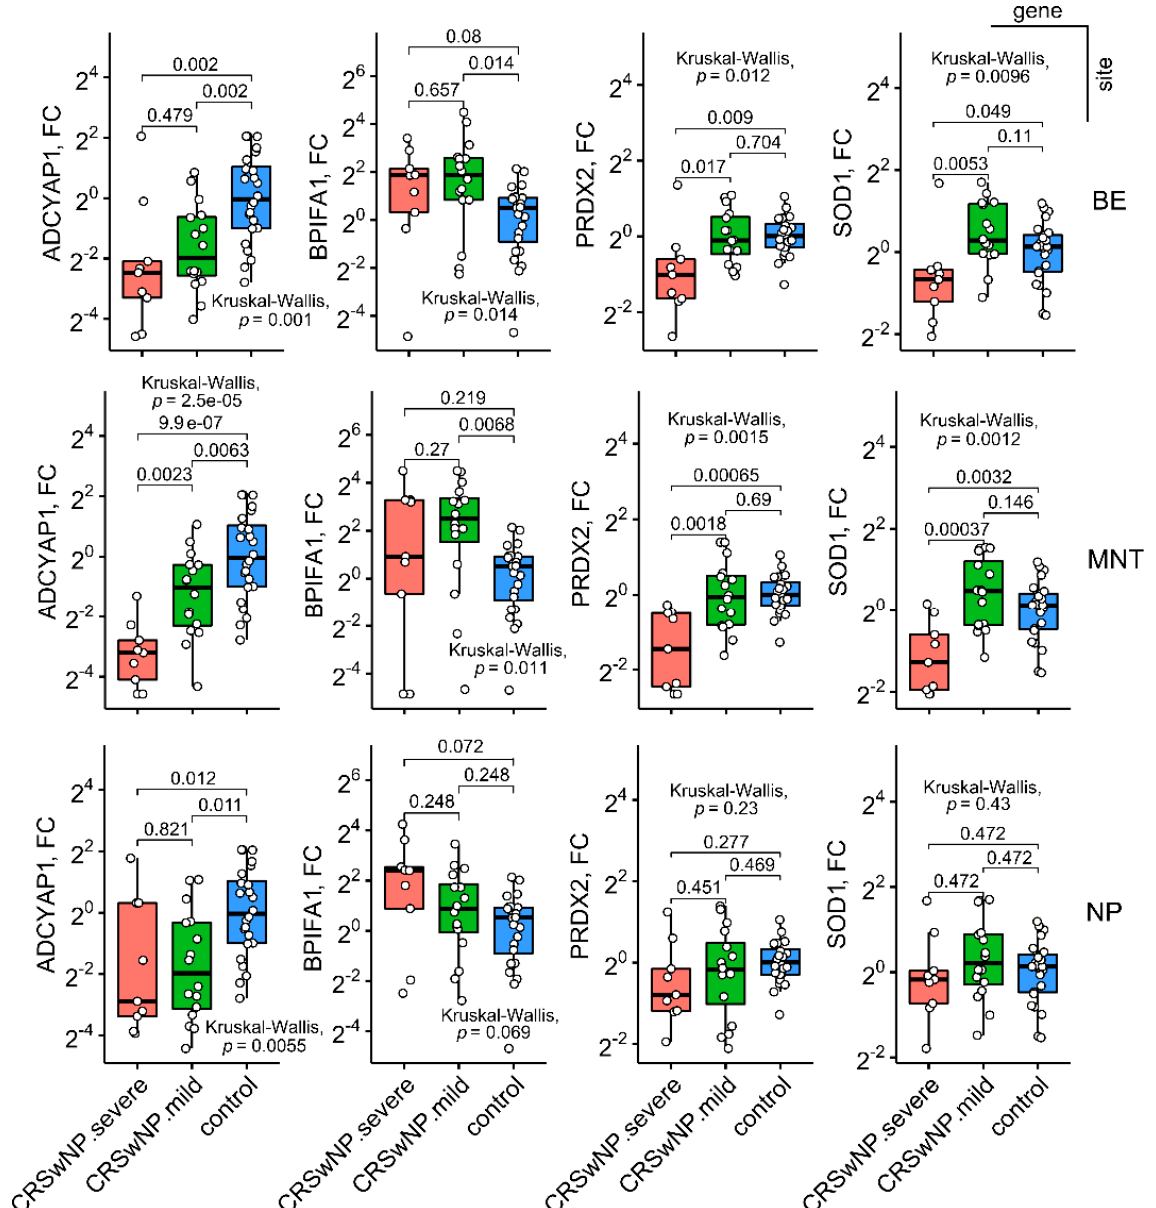
Figure 2. Boxplots showing gene expression (fold change (FC), log2-scale) in annotated groups, according to the Lund–Mackay CT score (two-tailed Kruskal–Wallis test, Conover’s post hoc test, false discovery rate correction). Horizontal lines represent median with interquartile range. p < 0.05 was considered significant. BE: bulla ethmoidalis, MNT: middle nasal turbinate, NP: nasal polyp. n (CRSwNP.severe) = 9, n (CRSwNP.mild) = 16, n (control) = 24 .